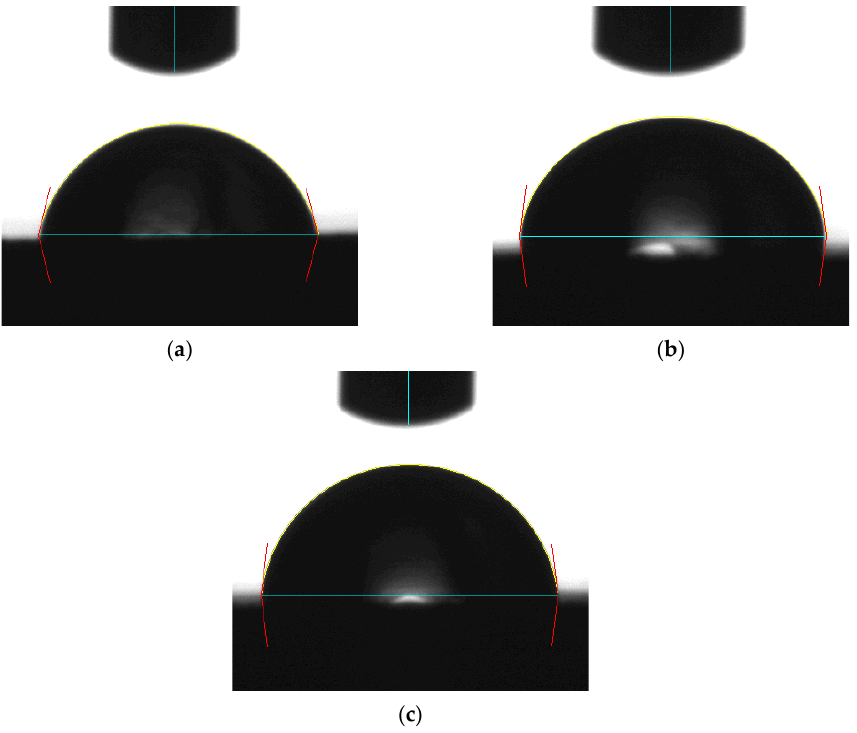
Figure 4. Typical contact angle images of distilled water on Parylene C coated on substrates with a Shore A hardness of ( a ) 50, ( b ) 85, and ( c ) 95.